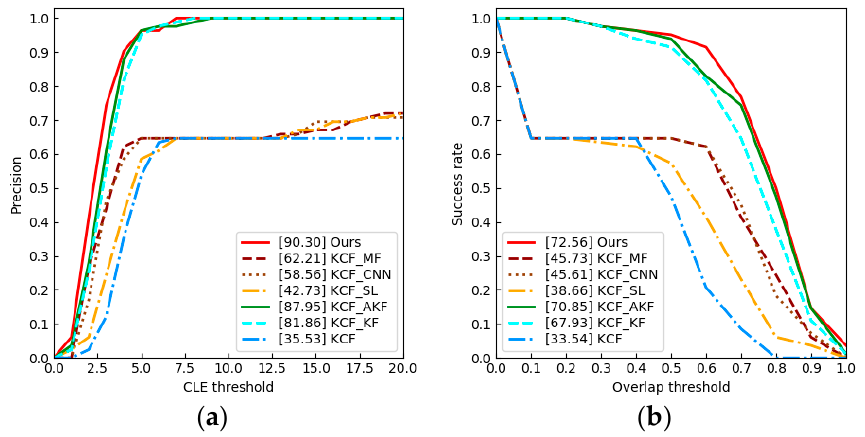
Figure 8. Ablation study on all the occluded video sequences. The legend in the precision and success plot are the precision and AUC value score per object tracker, respectively. ( a ) Precision plots; ( b ) Success plots.